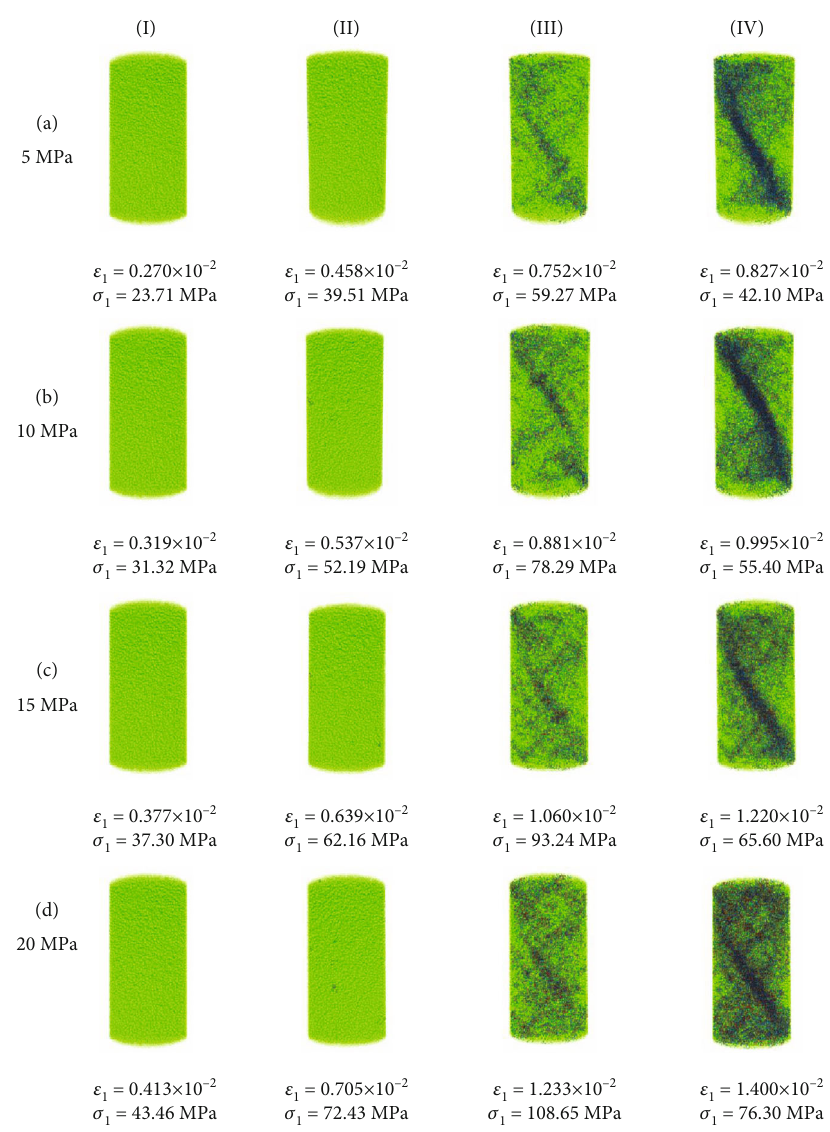
Figure 11: Internal crack propagation rules of red sandstone under di ff erent con fi ning pressure